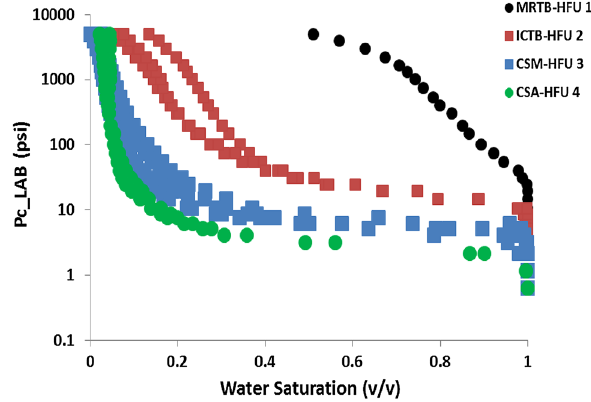
Fig. 14 Measured capillary pressure curves indicating a relationship between the various hydraulic flow units and capillary parameters. Reservoir quality properties increase from the black curve (HFU 1— mud rich thin bed units) with high irreducible water saturation and entry pressures to the green curve (HFU 4—channel storey axis units) with low S wirr and P